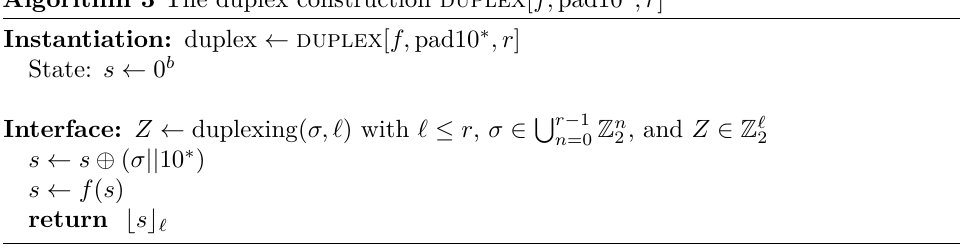
Algorithm 3 The duplex construction duplex [ f, pad10 ∗ , r